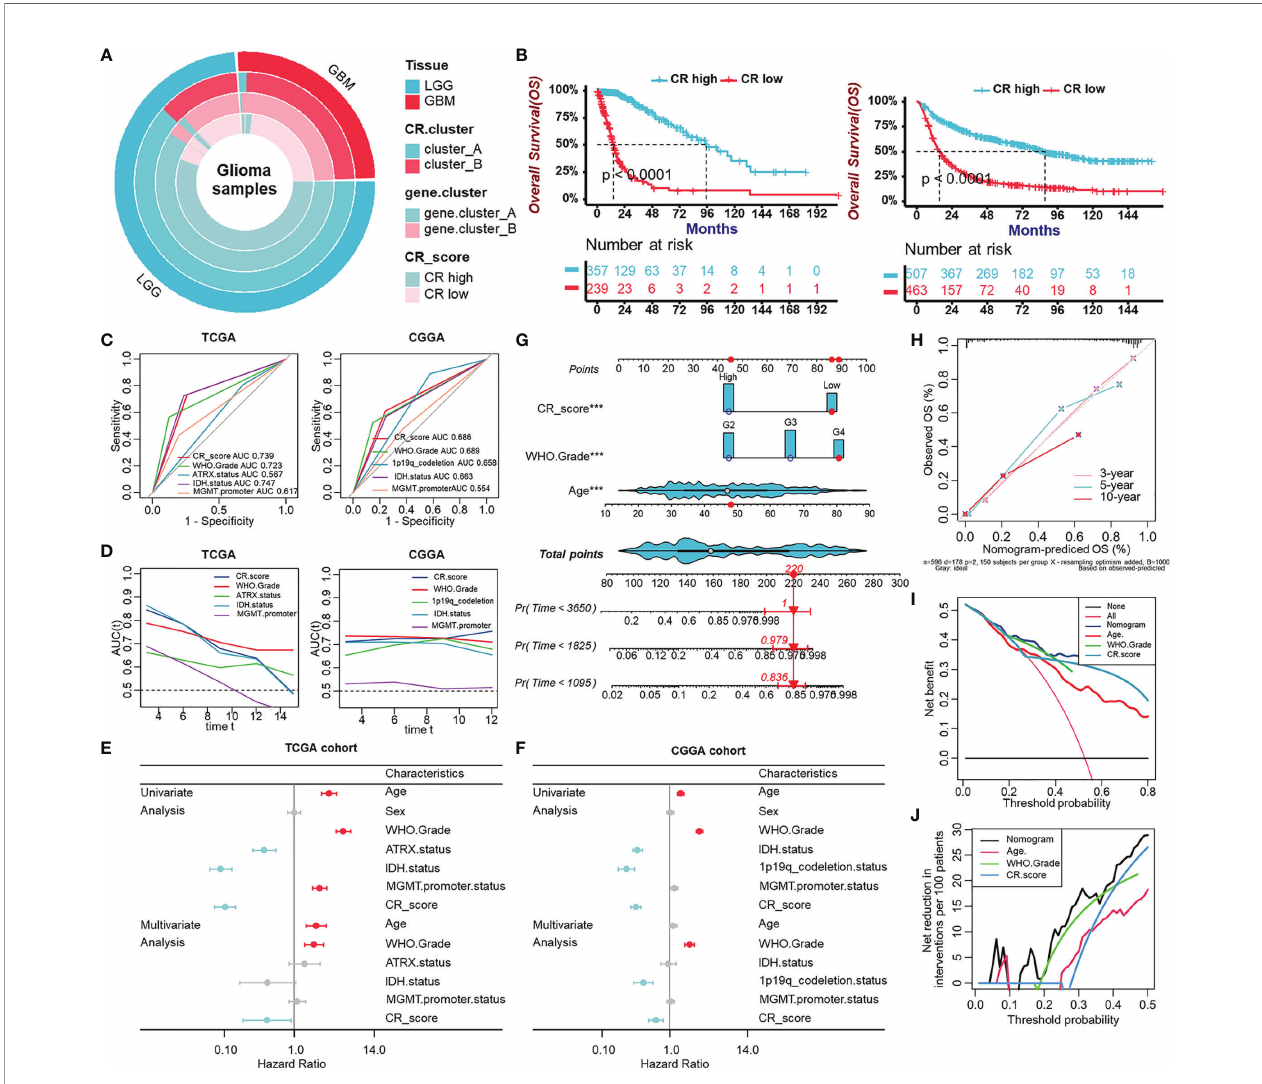
FIGURE 6 | Evaluation of the prognostic potentiality of the CRscore. (A) The overlap among tissue types, CR clusters, gene clusters, and CR groups. (B) Survival analyses for CR groups in the TCGA cohort (left) including 357 cases in the CR-high group and 239 cases in the CR-low group (Log-Rank test, p < 0.0001), and in the CGGA (right) cohort including 507 cases in the CR-high group and 463 cases in the CR-low group using Kaplan – Meier curves (Log-Rank test, p < 0.0001). (C) Predictive accuracy at 5-year of CRscore compared with other histological or molecular indicators in TCGA (left) and CGGA (right) cohort, respectively. The accuracy was equal to the area under the ROC curves (AUC). (D) Time-dependent AUC of CRscore compared with other histological or molecular indicators in the TCGA (left) and CGGA (right) cohort, respectively. (E, F) Univariate and multivariate analyses of clinicopathological characteristics and CRscore with overall survival in the TCGA (E) and CGGA (F) cohort, respectively. (G) Nomograms for predicting the probability of patient mortality based on WHO Grade, CRscore, and age. (H) Plots depicted the calibration of nomograms. (I) Net decision curve analyses demonstrating the bene fi t for predicting overall survival on nomogram. (J) The net reduction analyses demonstrated in how many patients the nomogram could be avoided without prognosis of